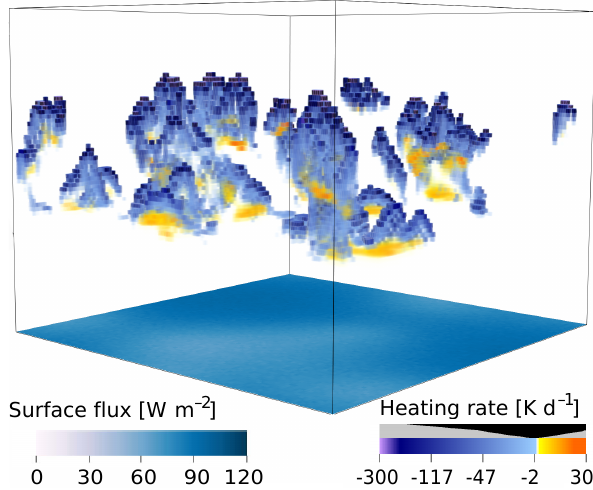
Figure 1. Three-dimensional heating and cooling rates and surface fluxes in a cumulus cloud field, calculated with the Monte Carlo model MYSTIC (Mayer, 2009; Klinger and Mayer, 2014). The black and gray bar shows the opacity of heating